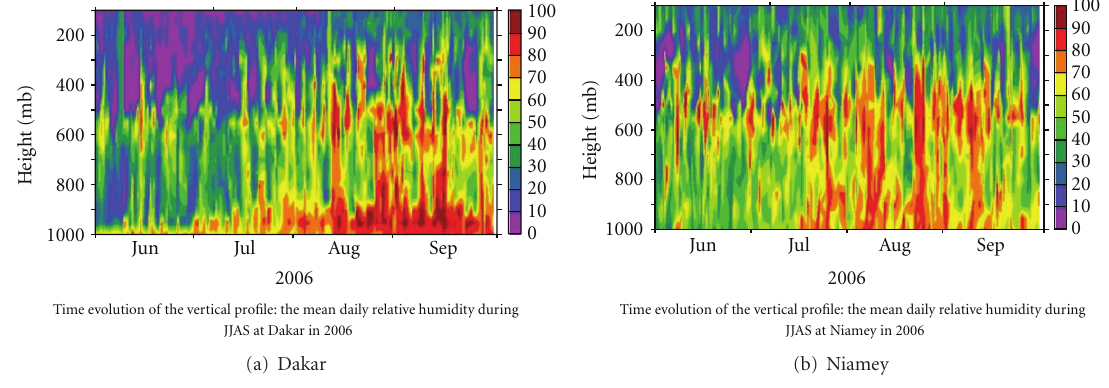
Figure 5: Daily humidity profiles in Dakar and Niamey at 0000 UTC and 1200 UTC of 2006 JJAS.